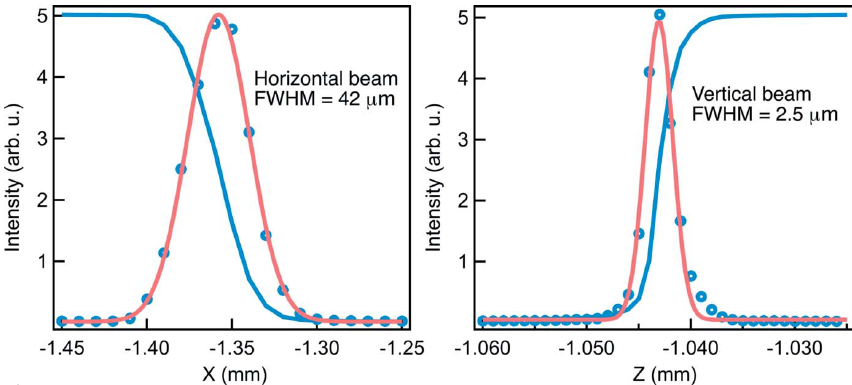
Figure 3 The measured focal beam size at the sample position with VPG2 at 1 keVand the exit slit opening at 10 m m FWHM. The blue open circles are the first derivative of the blue curve from a knife-edge scan, and the pink curve is the Gaussian